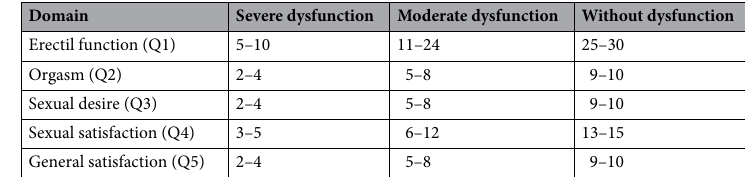
Table 1. Classification of male sexual function through the domains of the international index of erectile function and values assigned to each domain by this index.